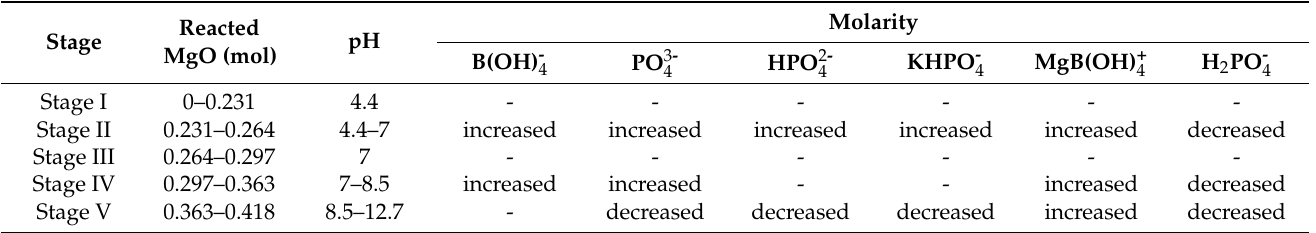
Table 7. Stages in the evolution of the molarity of the ions in the MKPC solution with boric